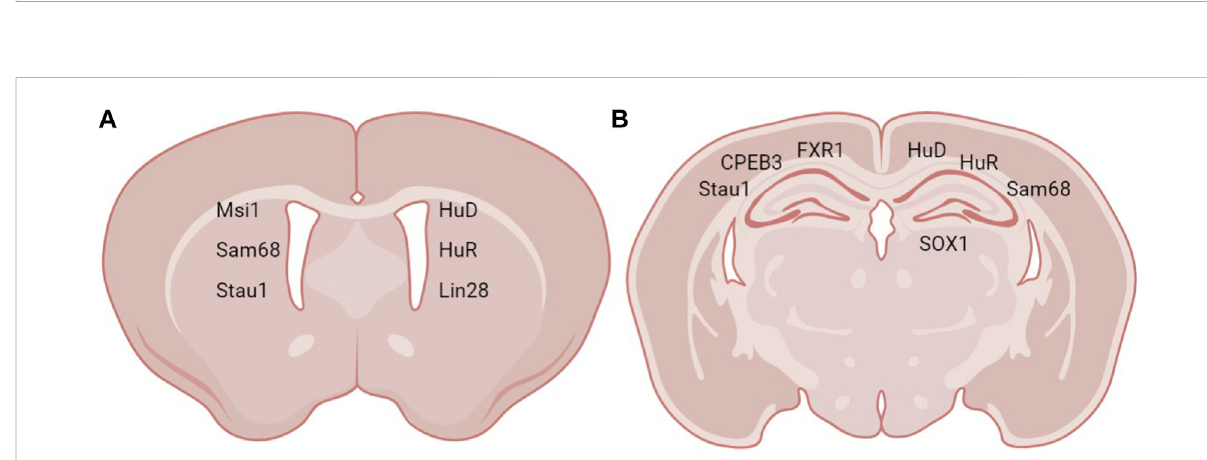
Frontiers in Cell and Developmental